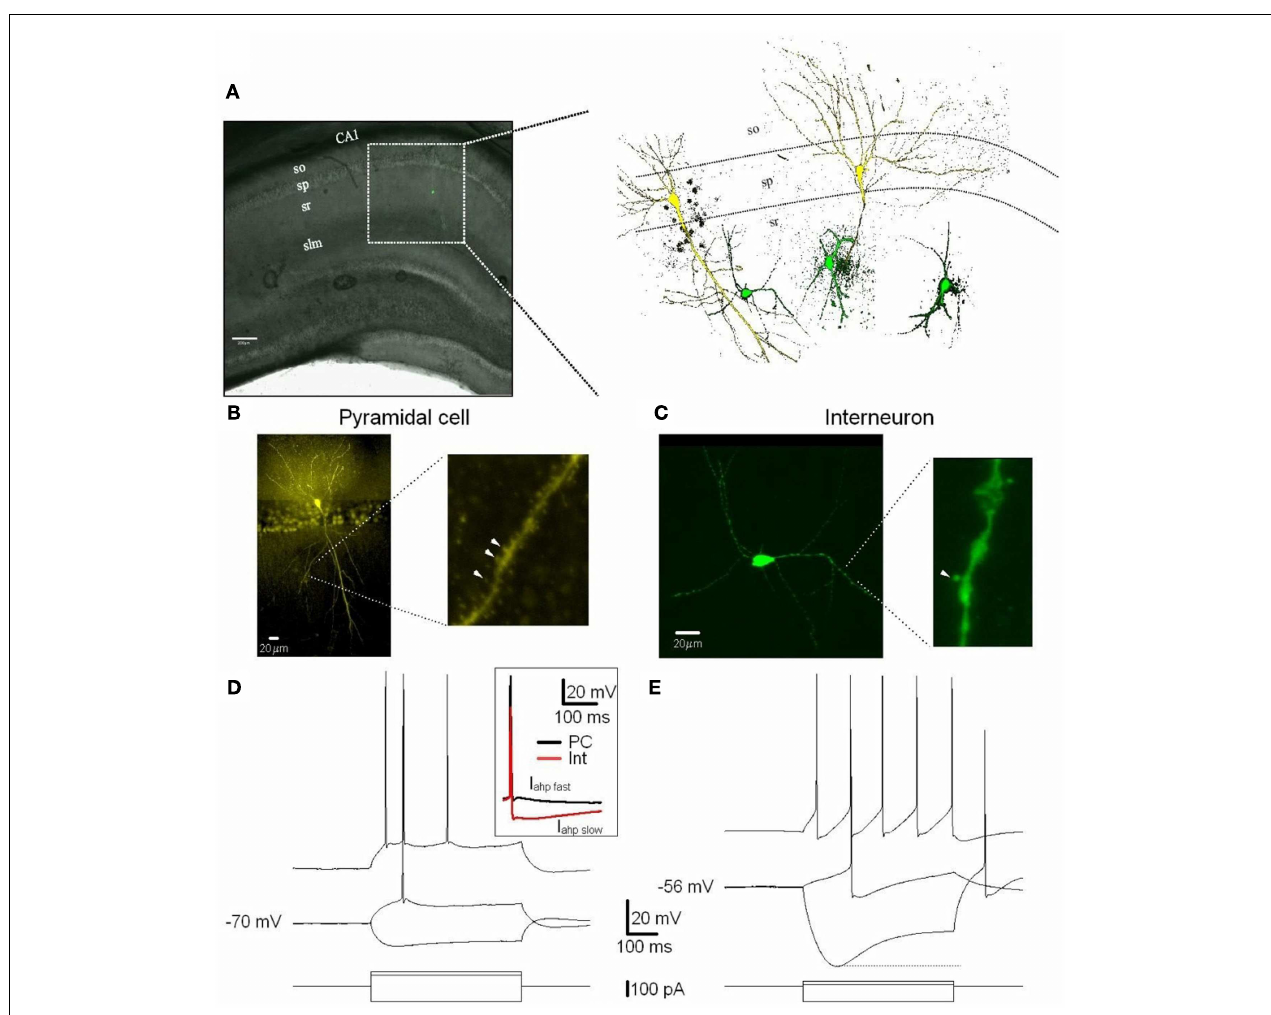
and (C) right expanded confocal images of dendritic spines. Note the spiny dendritic segment of the PC (B) in contrast with the a-spiny (C) one of the Int.The arrowheads indicate dendritic spines. (D,E) Voltage responses of one PC and one Int (top), to a series of intracellular current pulses (bottom) are shown.The current was applied at rest ( − 70 and − 56mV for PC and Int, respectively). Inset, action potentials from a PC and Int are superimposed. Note the larger I ahp in Int compared to PC. Abbreviations: so, stratum oriens; sp, stratum pyramidale; sr, stratum radiatum; slm, stratus lacunosum moleculare. Scale bar: 200 µ